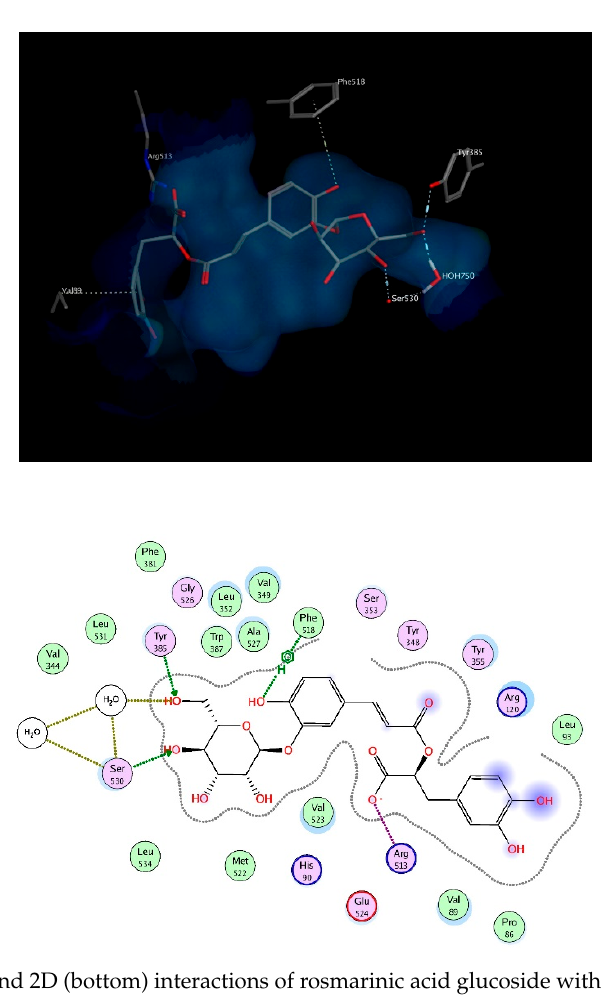
Figure 7. 3D (top) and 2D (bottom) interactions of rosmarinic acid glucoside with amino acid residues of COX-2. In the 3D view, side chains of amino acids were omitted for clarity.